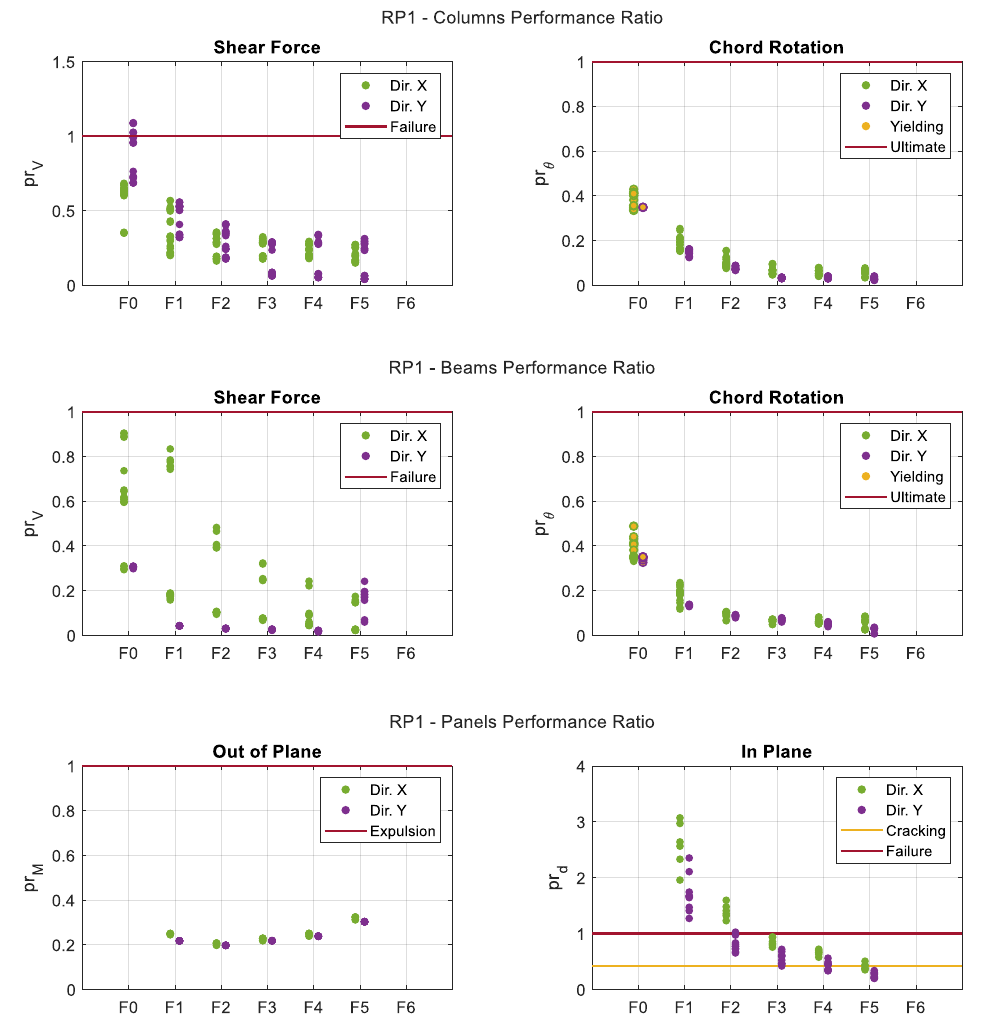
Figure 14. RP1 RC elements and infill panels performance ratios.